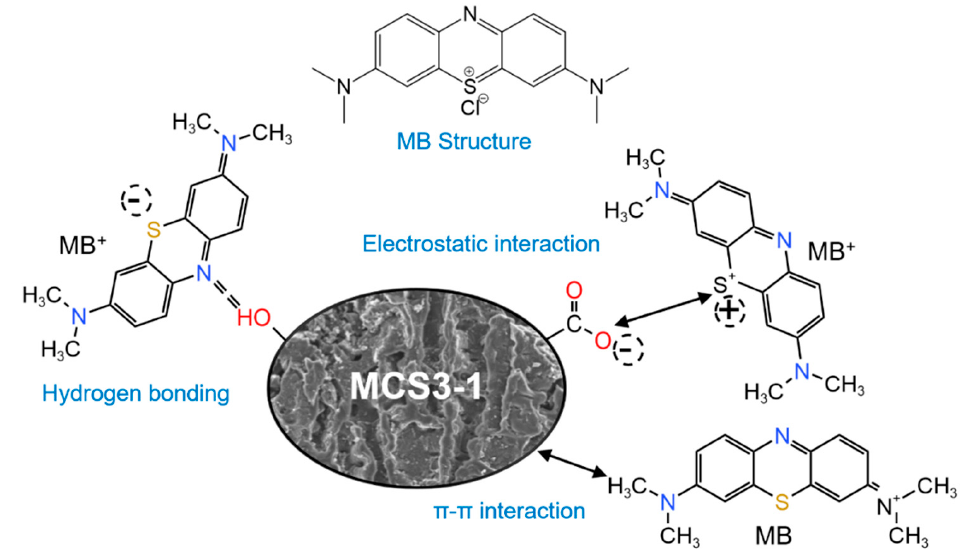
Figure 16. Structure of MB and mechanism of CN adsorption of MB.